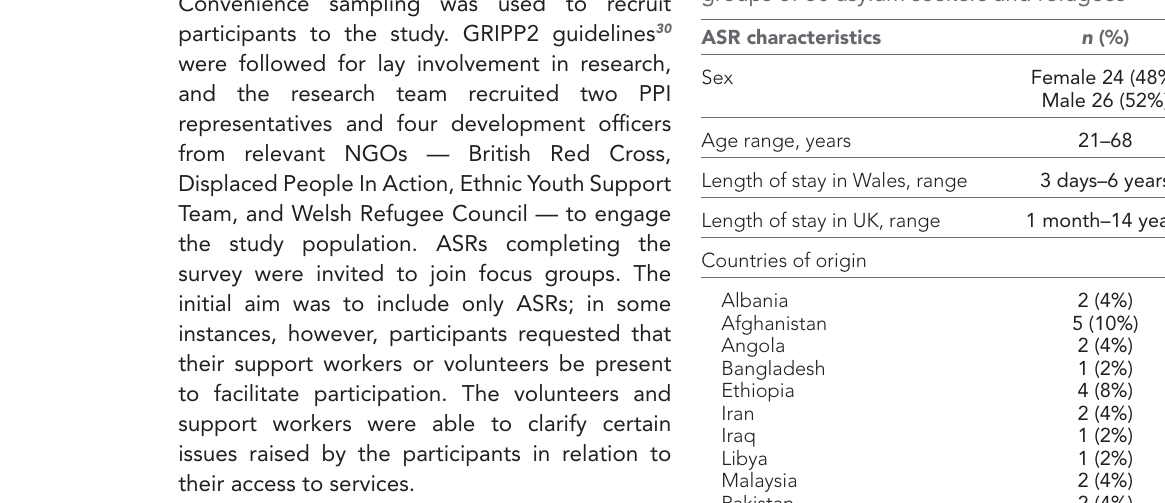
Table 1 Characteristics of participants in